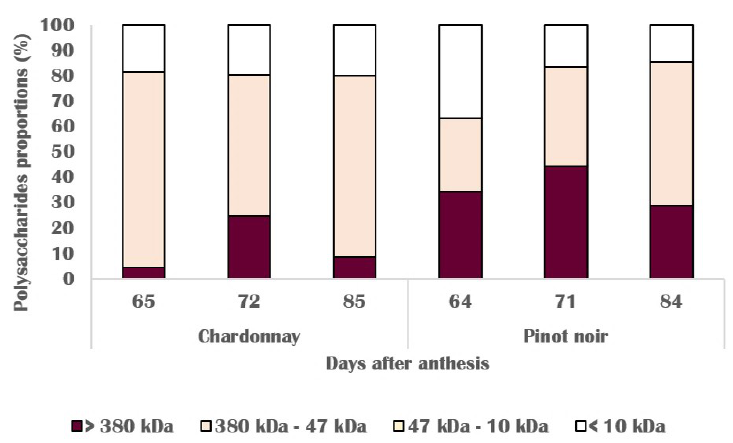
Figure 6. Proportions of pectic polysaccharides for Pinot noir and Chardonnay skin cell walls during ripening.